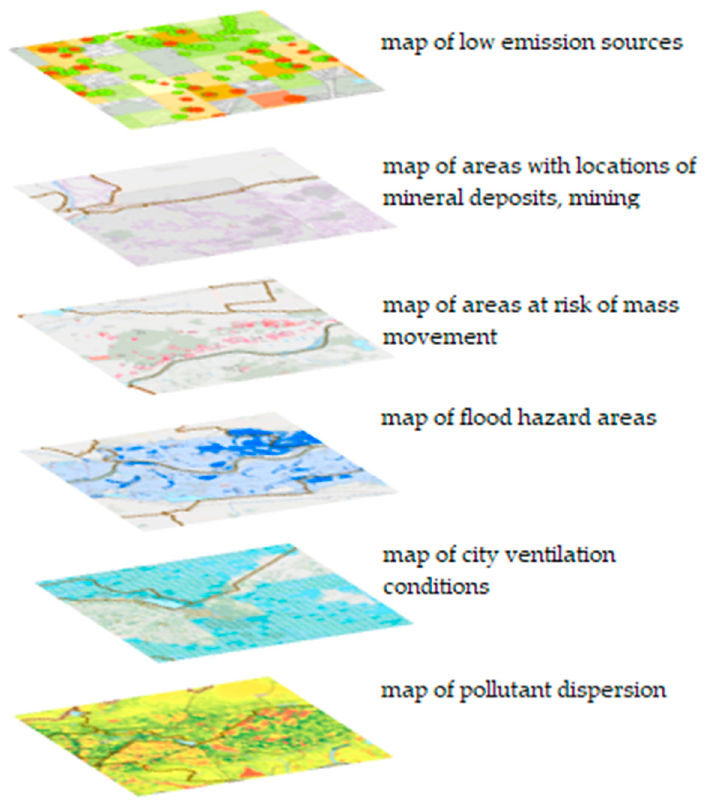
Figure 2. Map layers in the “Environmental management and protection” ISI. Source: Own research based on www.msip.um.krakow (accessed on 25 September 2019).